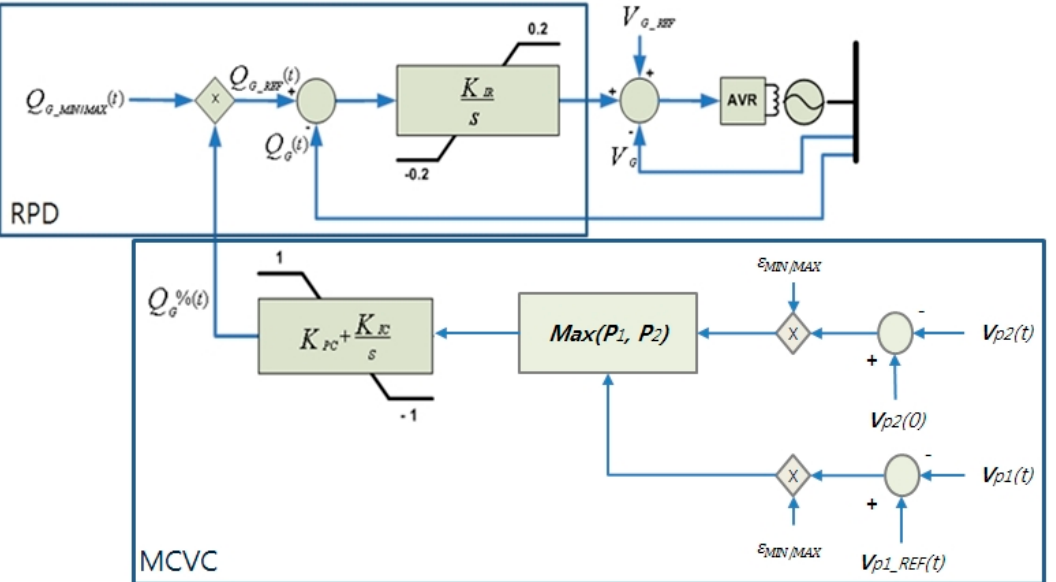
Table 1. Control parameters of the control generators in Korean power system.